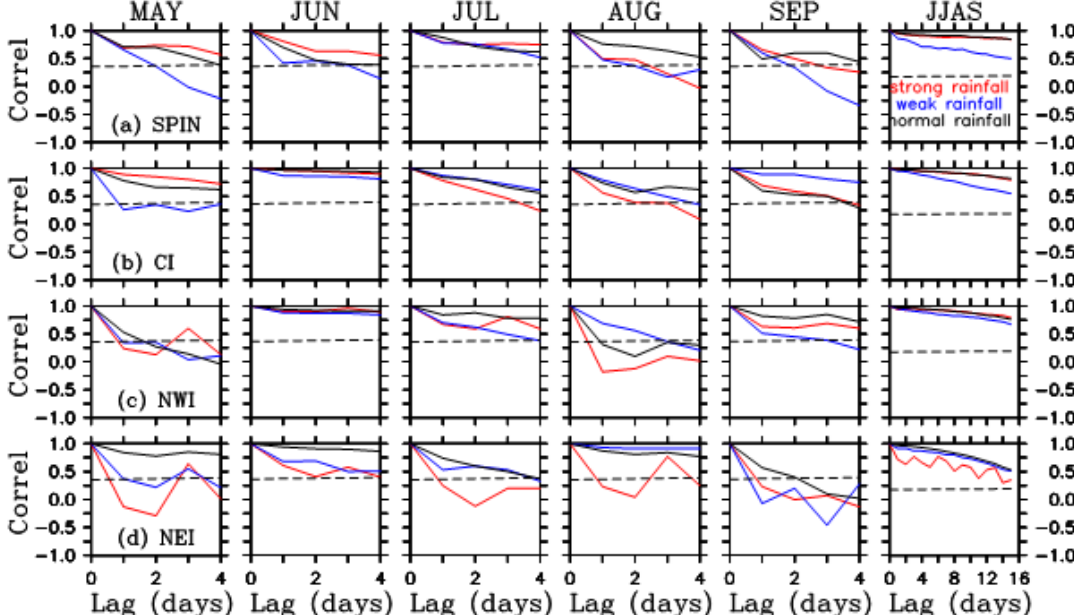
Figure 10. Lag autocorrelation for soil moisture averaged over ( a ) SPIN, ( b ) CI, ( c ) NWI, and ( d ) NEI for May, June, July, August, September, and JJAS during strong, weak, and normal ISMs. Red, blue, and black curves represent the lag auto correlation of daily mean soil moisture for strong, weak, and normal ISMs, respectively. The day of strong SM persistence is defined as the number of lag days when the auto-correlation coefficient first falls below the critical values (dashed lines) at the 95% confidence